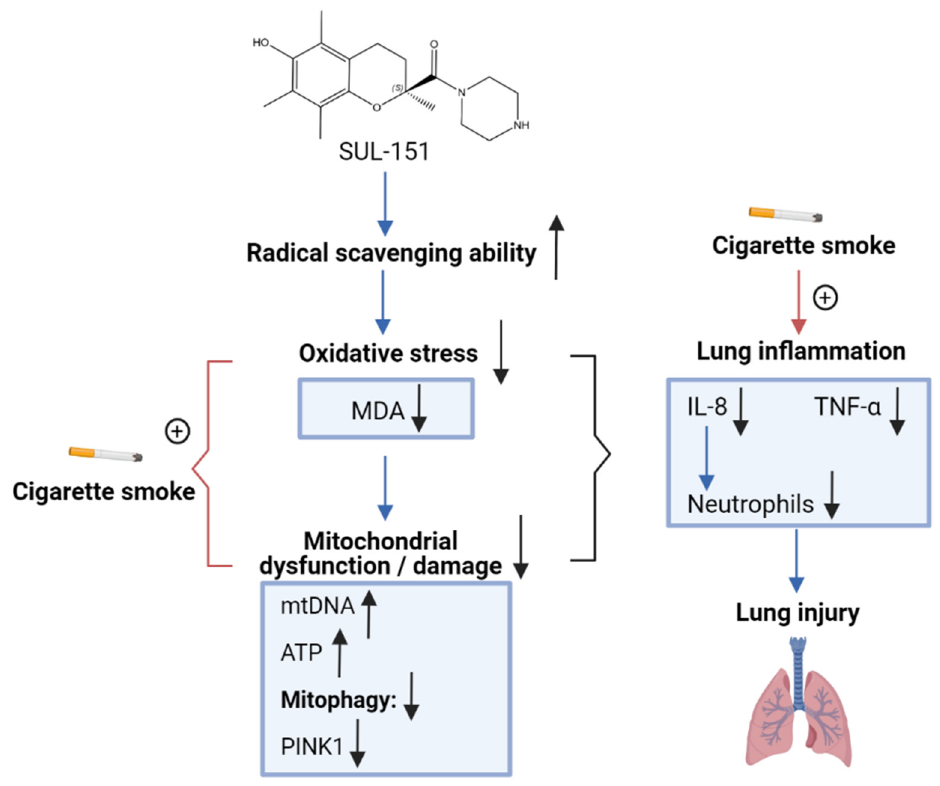
Figure 8. Schematic overview of the postulated mechanism of SUL-151 on CS-induced lung inflammation. SUL-151 has the ability to increase radical scavenging in the airways, possibly leading to a decrease in the CS-induced oxidative stress as measured by inhibition in MDA levels in lung homogenates. The decrease in oxidative stress might lead to a decrease in mitochondrial dysfunction/damage, as observed by the increase in mtDNA, the capacity to produce more ATP in the lungs, and the mitoprotective properties measured by a decrease in PINK1 expression. In this regard, the CS-induced oxidative stress and mitochondrial dysfunction can be inhibited by SUL-151, in turn leading to a decrease in CS-induced lung inflammation.